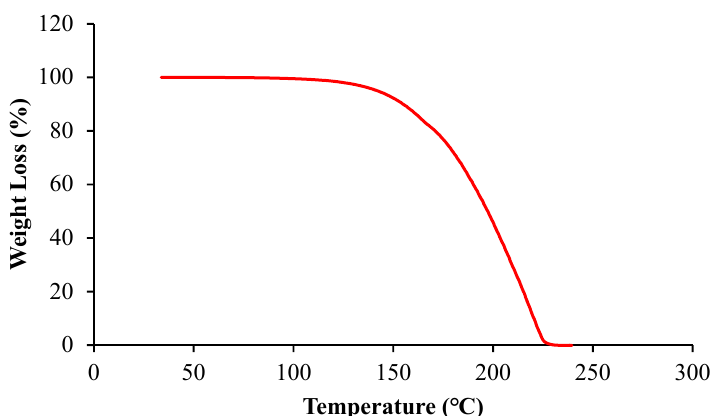
Figure 12. Thermogravimetry analysis ( TGA) graph of PCM used in this study.